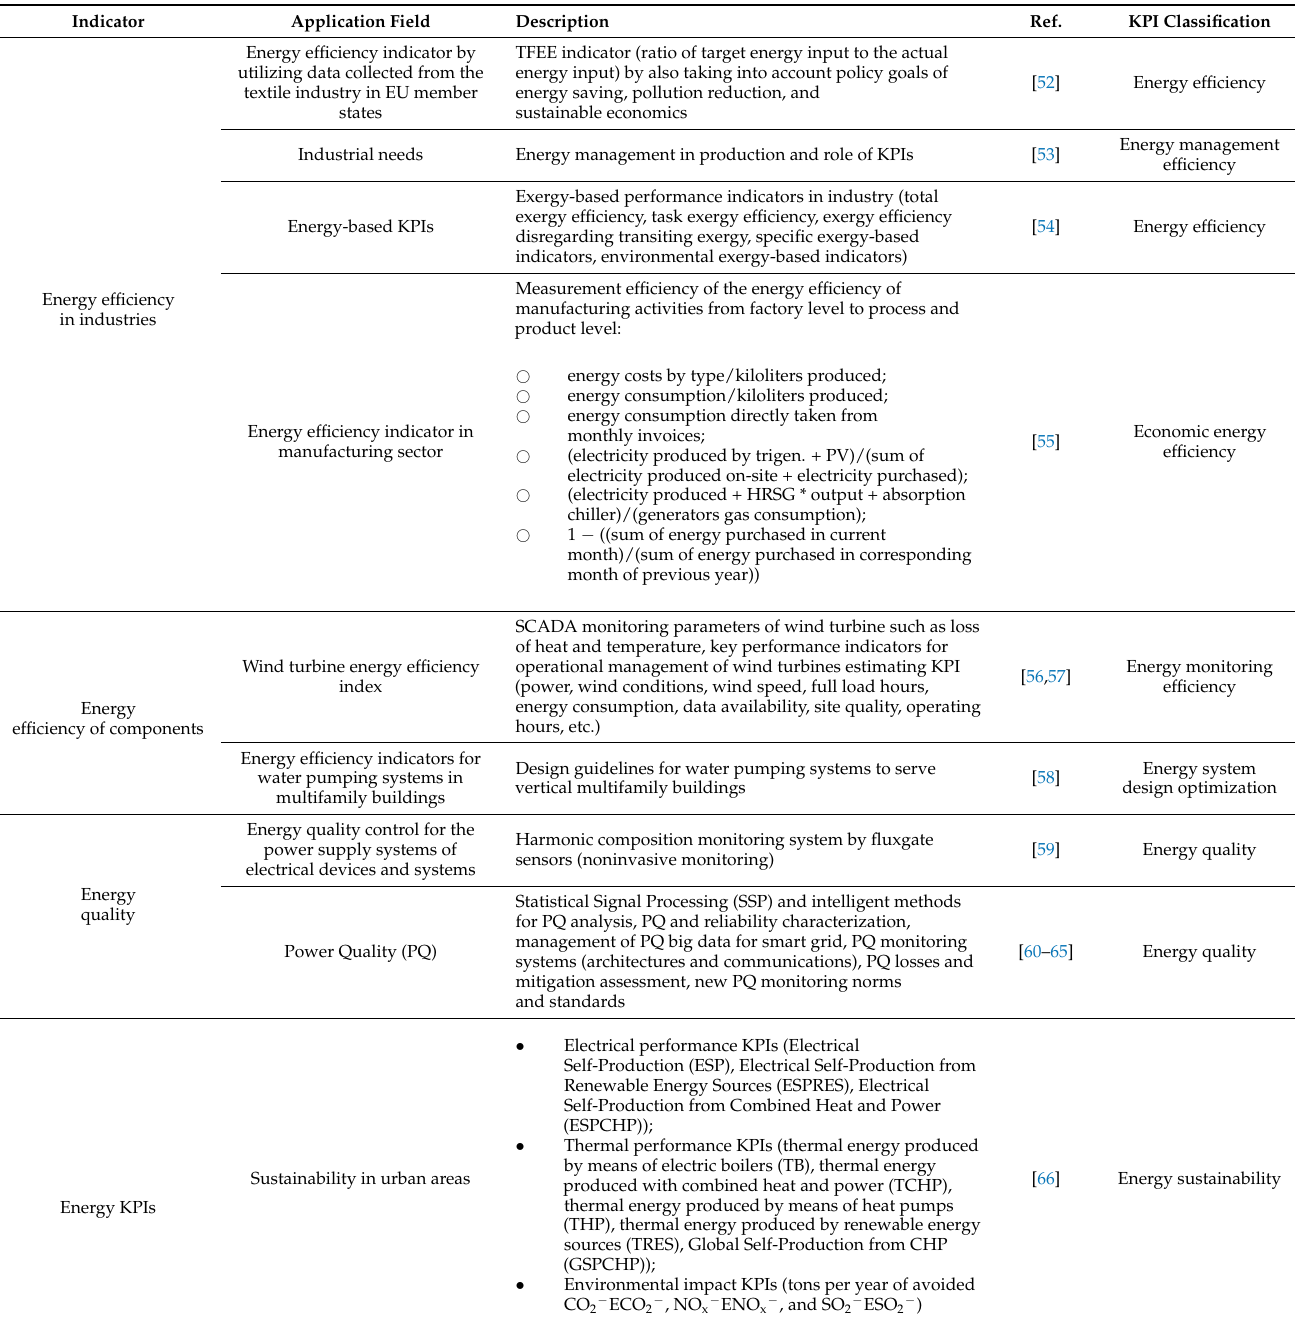
Table 4. State of the art: energy